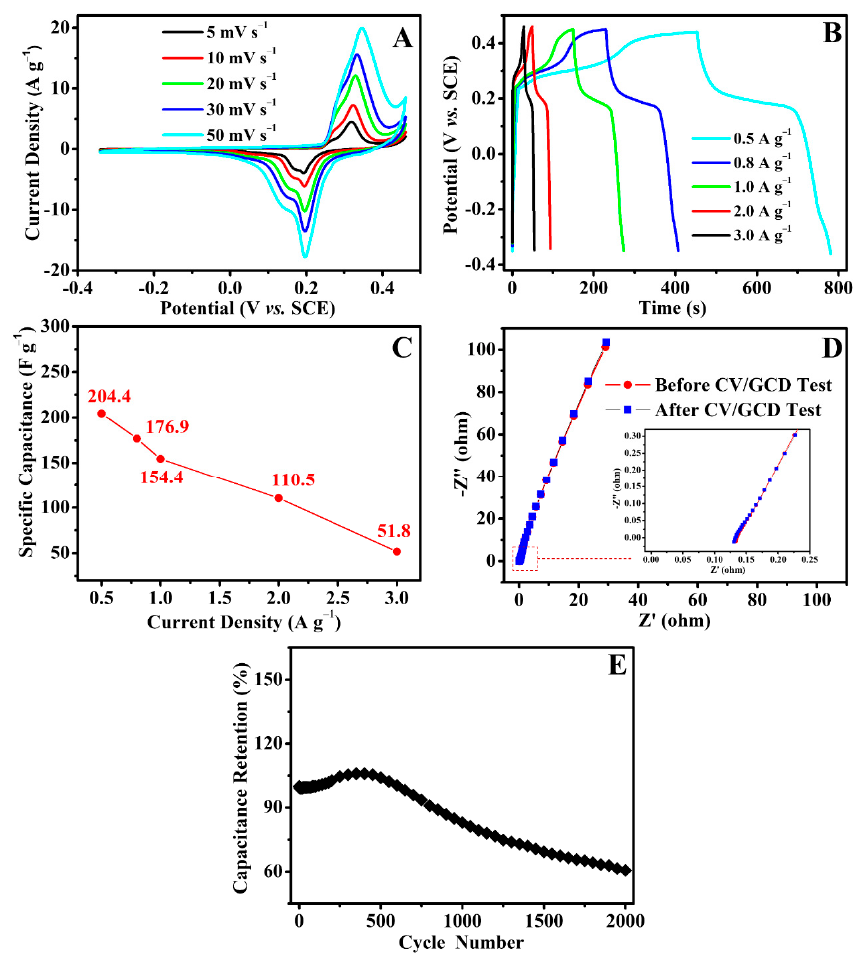
Figure 6. ( A ) CV profiles obtained from the carbon nanofibrous felt electrode at the scanning rates of 5, 10, 20, 30, and 50 mV s − 1 ; ( B ) GCD curves of the electrode at different current densities; ( C ) specific capacitance values of the electrode at varied current densities; ( D ) Nyquist plots of the electrode before and after CV/GCD test; ( E ) cycling stability of the carbon nanofibrous felt elec- trode at 5 A g − 1 2000